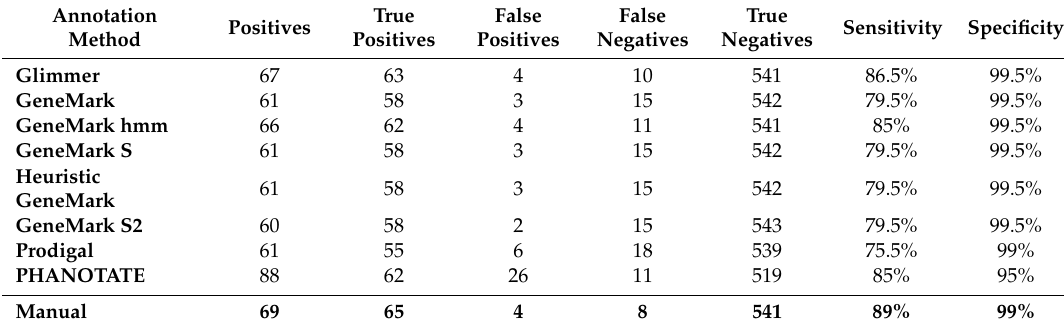
Table 1. Results of gene identification in the genome of phage Lambda. Sensitivity and specificity are rounded to the nearest 0.5%.